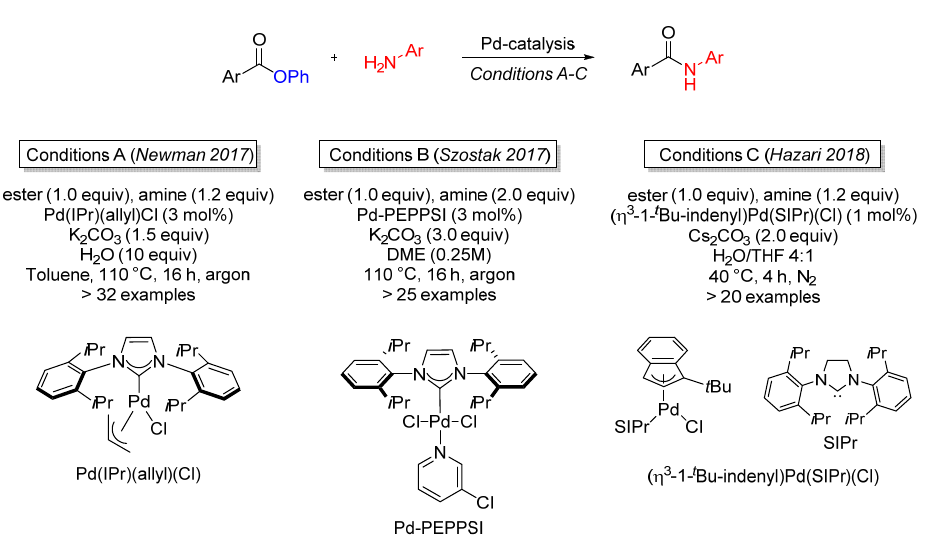
Scheme 32. Palladium-catalyzed cross-coupling of aryl esters and anilines.